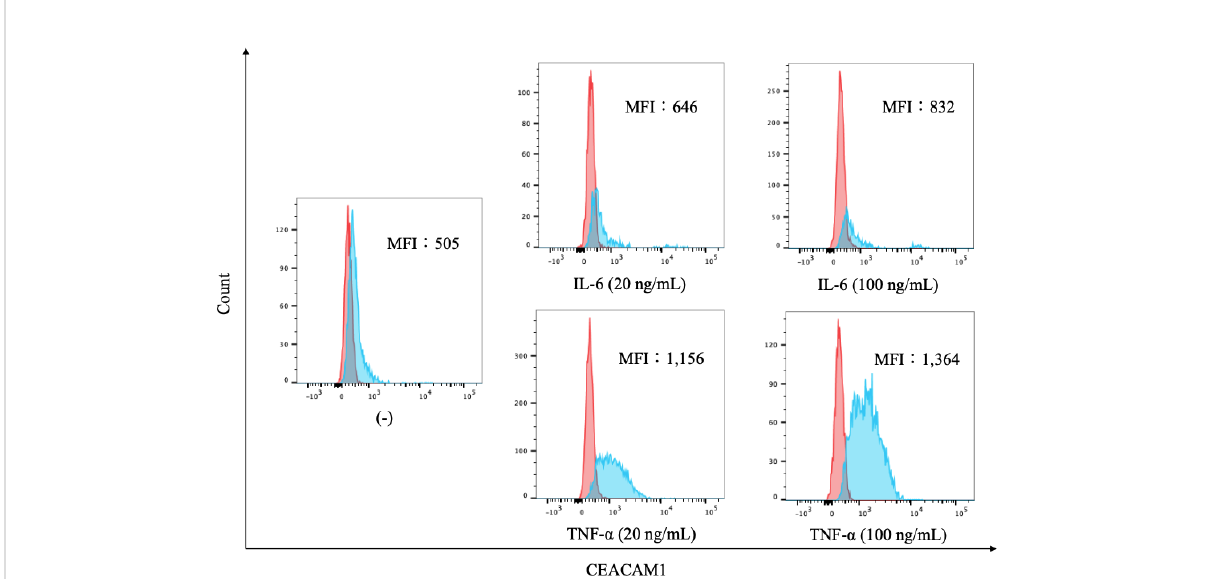
FIGURE 4 The expression of CEACAM1 on cytokine-stimulated neutrophils. Flow cytometry overlay histograms for CEACAM1 demonstrating typical cell pro fi les from subdivided peripheral blood immune cells from HC. CEACAM1 expression was detected using anti – CEACAM1 antibody (blue shaded histogram) or isotype control antibody (red shaded histograms). Neutrophils were stimulated with cytokines associated with in fl ammatory pathogenesis of RA [IL-6 (20 ng/mL and 100 ng/mL) and TNF- a (20 ng/mL and 100 ng/mL)]. The MFI of CEACAM1 differed depending on the cytokine and its concentrations. HC, healthy controls; IL-6, interleukin-6; TNF- a : tumor necrosis factor; MFI, mean fl uorescence intensity.